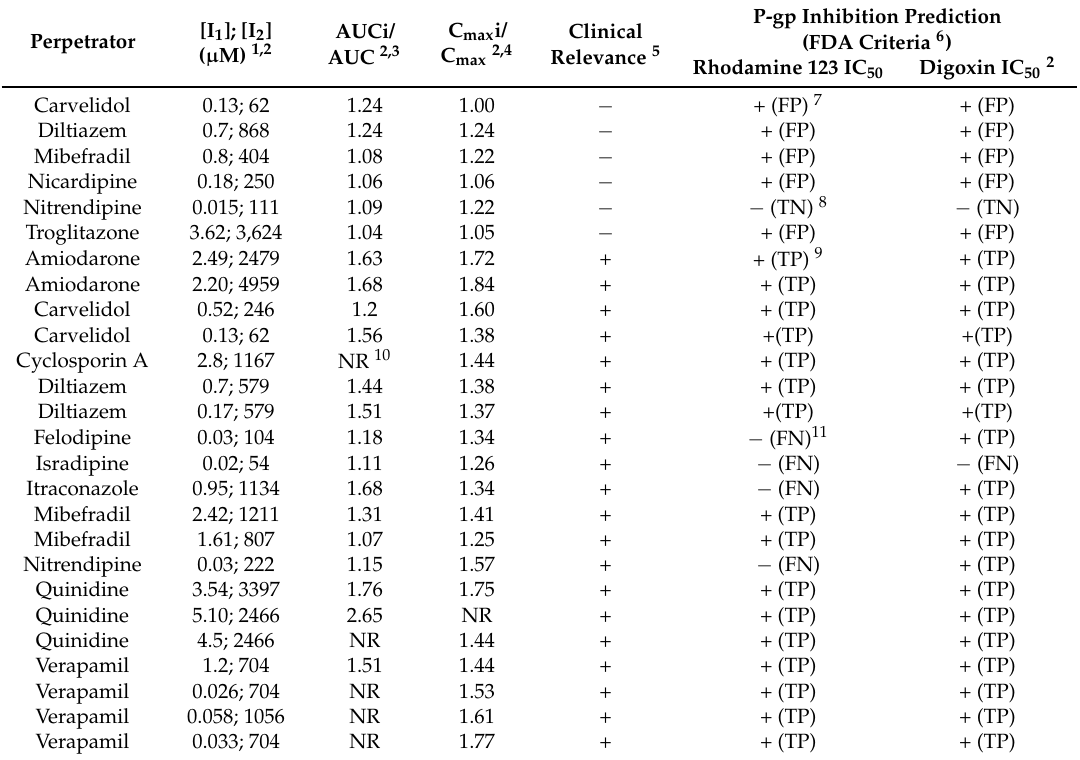
Table 2. Prediction of P-gp inhibition in 26 clinical DDI studies with digoxin as a victim drug, using FDA criteria and P-gp IC 50 values from rhodamine 123 accumulation or digoxin bidirectional transport [41] assays.